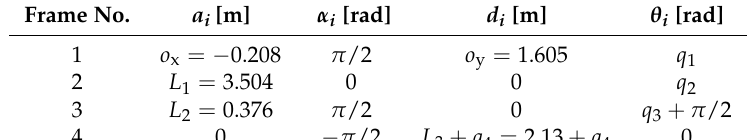
Table 2. Denavit-Hartenberg parameters of the 4-DOF hydraulic manipulator. Frame No.